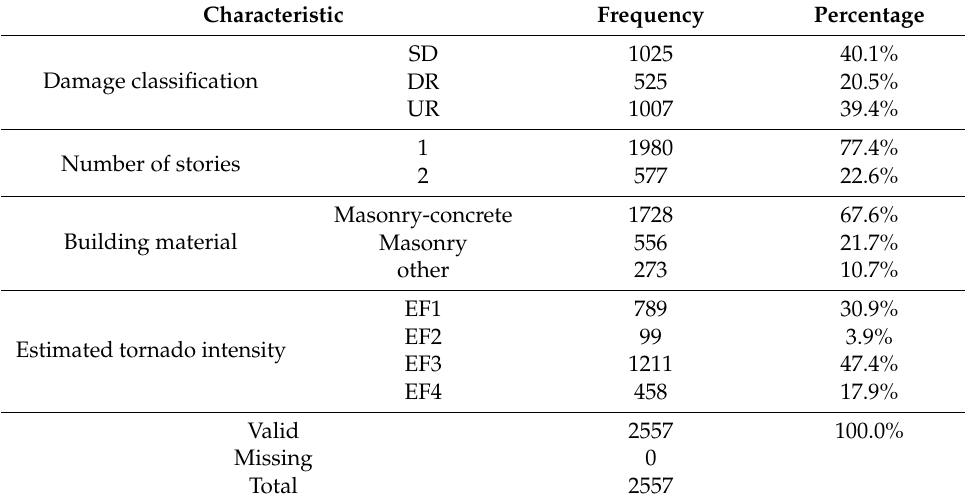
Table 3. Descriptive statistics of housing damage.